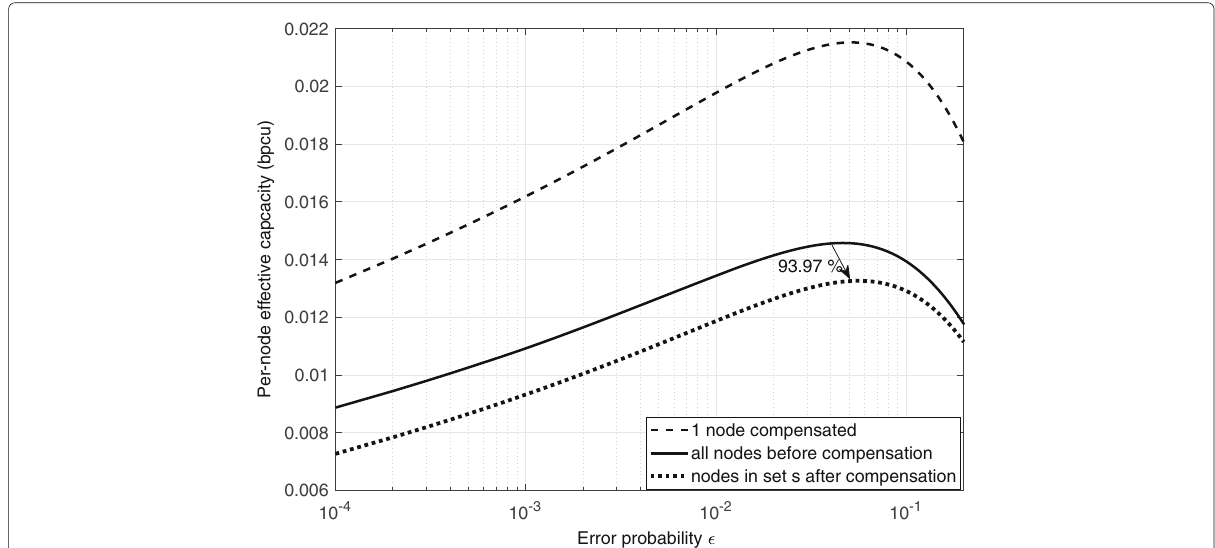
Fig. 10 Joint compensation. Per-node effective capacity as a function of error probability (cid:2) before and after joint compensation for T f = 1000, θ 1 = 0.1, ρ = 2, and N =